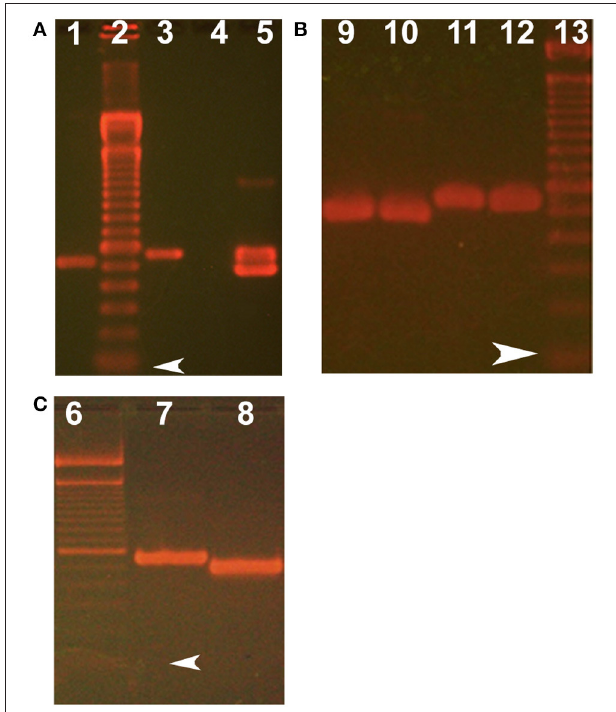
FIGURE 7 | Ethidium bromide stained agarose gels show size of products from PCR and subcloning lipocalin-interacting membrane receptor. (A) Shows RT-PCR products from corneal epithelium. (B) Shows plasmid inserts from single colonies from subcloning of RT- PCR of conjunctiva. (C) Shows plasmid inserts from single colonies from subcloning the PCR products of the corneal epithelial library. Lanes 2, 6, and 13 show 100 base pair molecular weight markers, arrowheads show the first marker at 100 base pairs. Target products lane 1 keratin 14 (control for cornea) using forward primer